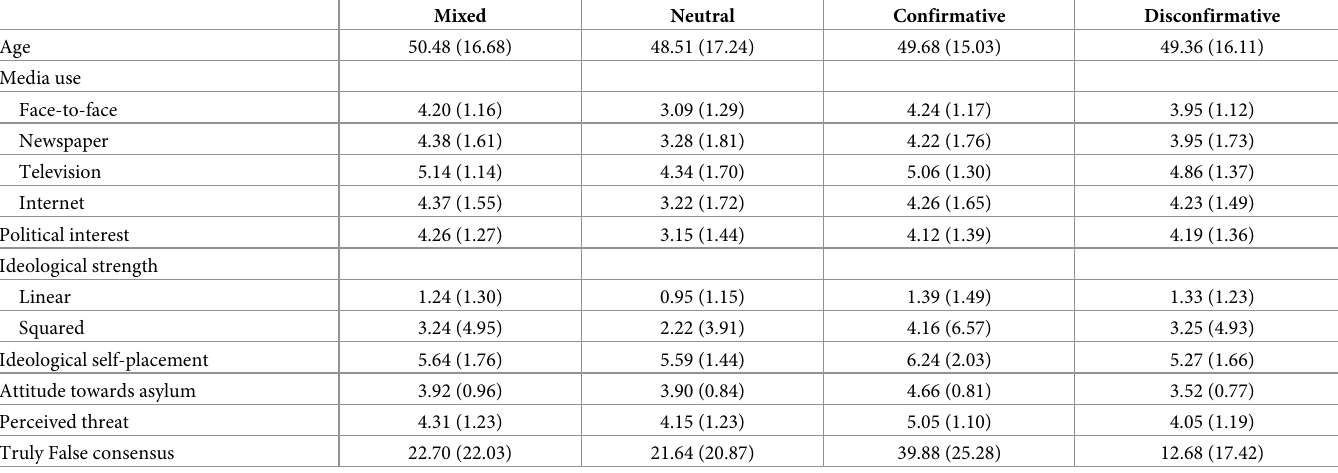
Table 3. Distribution of mean scores across categories of information environments.